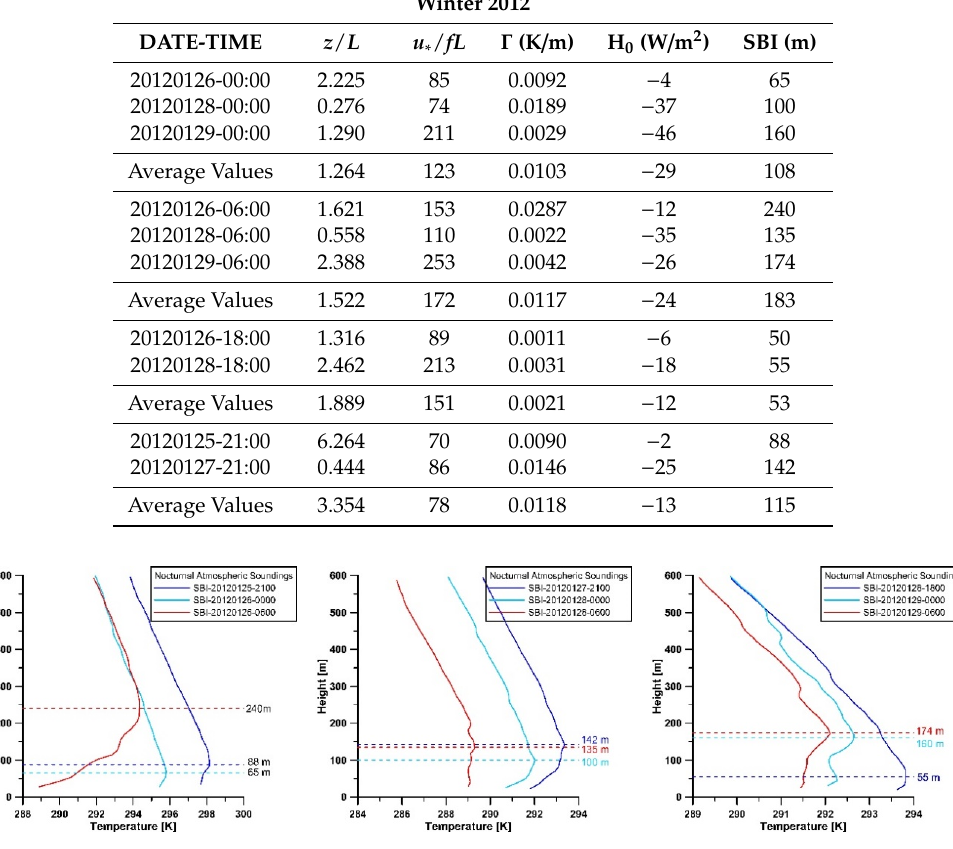
Figure 12. Estimation of the height of the stable boundary layer (SBL) of the Mexicali Valley from the surface-based inversions during the winter 2012 campaign. The graphs show the evolution of the surface-based inversion (SBI) from the first hours after sunset to 1 h before sunrise of the next day. Table 9. The nocturnal stability conditions of the Mexicali Valley during the autumn 2016 campaign. The height of the SBL estimated from surface-based inversion.